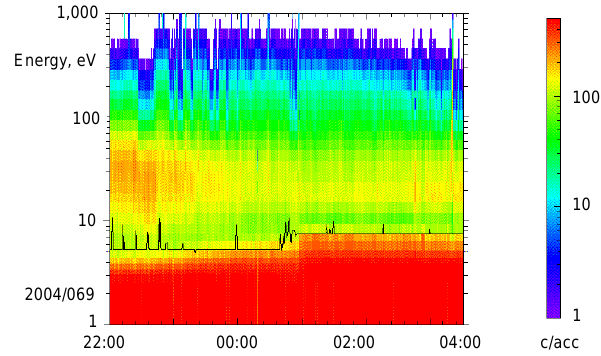
Fig. 10. Example of onboard spacecraft potential estimation. Data is from TC-1 on 9/10 March 2004 in the solar Figure 10. Example of onboard spacecraft potential estimation. Data is from TC-1 on March 09 th /10 th 2004 in the solar wind.